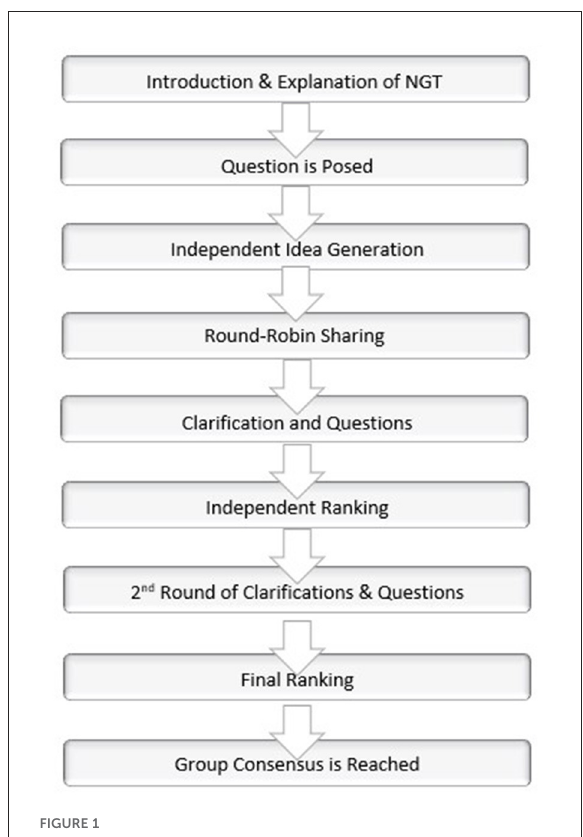
FIGURE1 Nominal group technique (NGT)